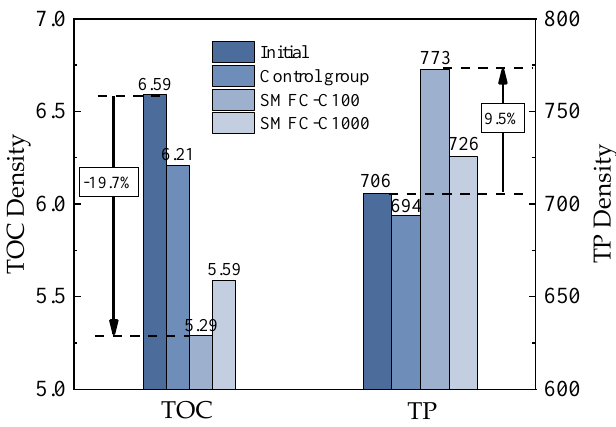
Figure 9. Comparison of TOC and TP data before and after the experiment.